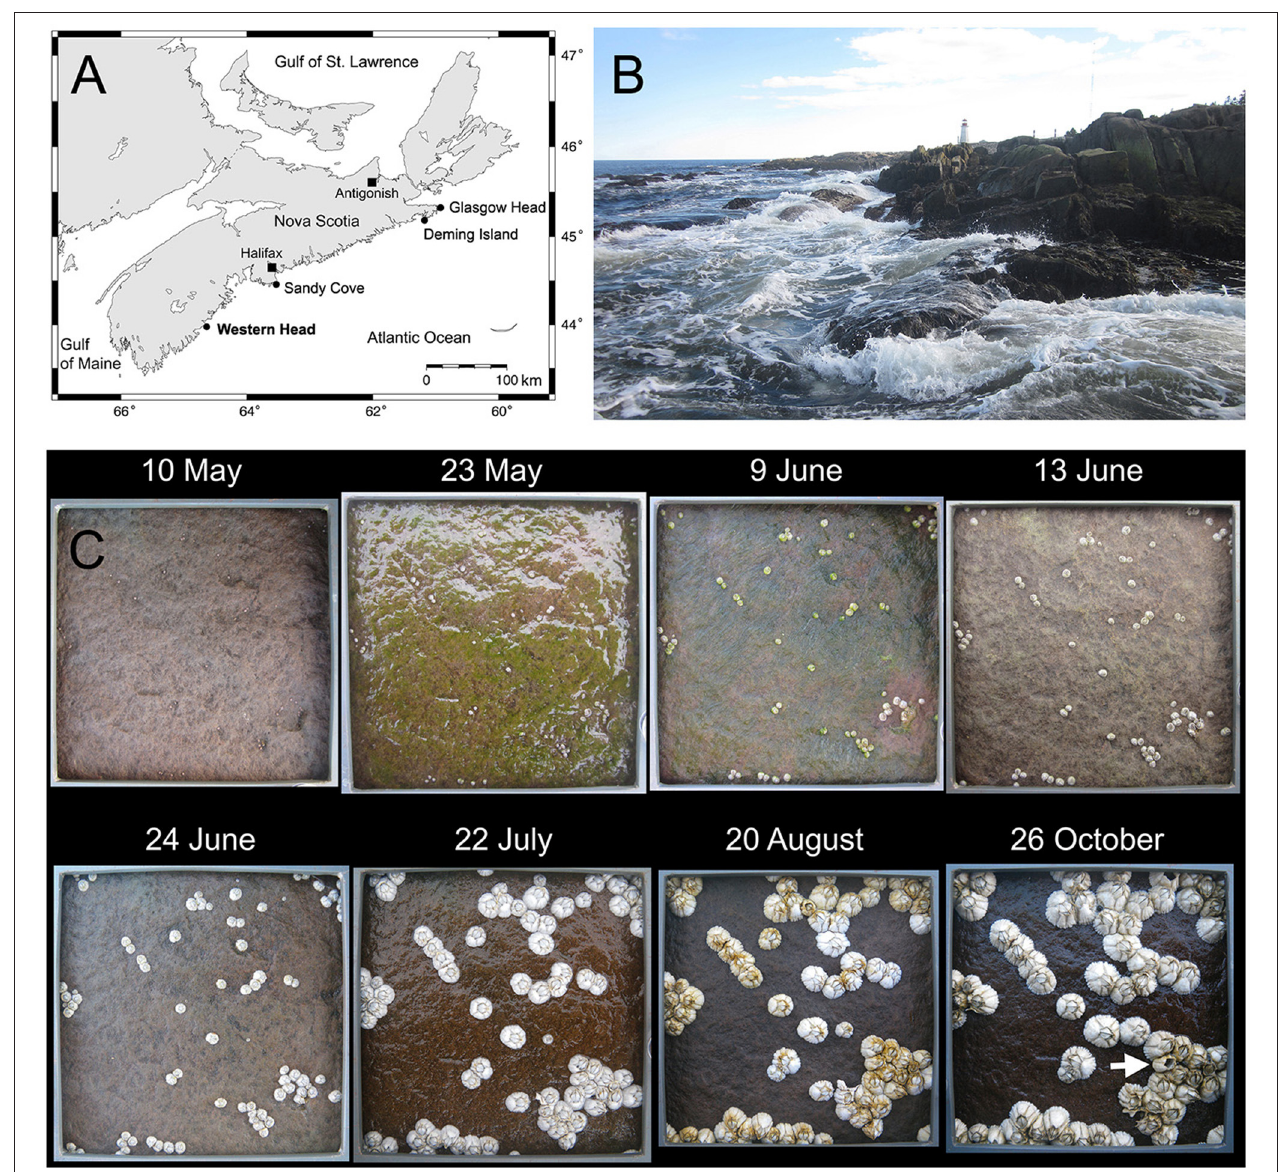
FIGURE 1 | (A) Map showing the position of Western Head and other intertidal locations from the Nova Scotia coast mentioned in the text. (B) View of the coast of Western Head during a low tide. (C) Photographs of one of the clearings taken at low tide on eight representative sampling dates (see section Materials and Methods for the full list of sampling dates). Each photograph shows the inner frame (10cm × 10cm) of the PVC quadrat that was used as a size reference to measure the body size of each barnacle recruit. The arrow in the photograph for the last sampling date points to a dead barnacle (empty shell). These photographs were taken by R. A.